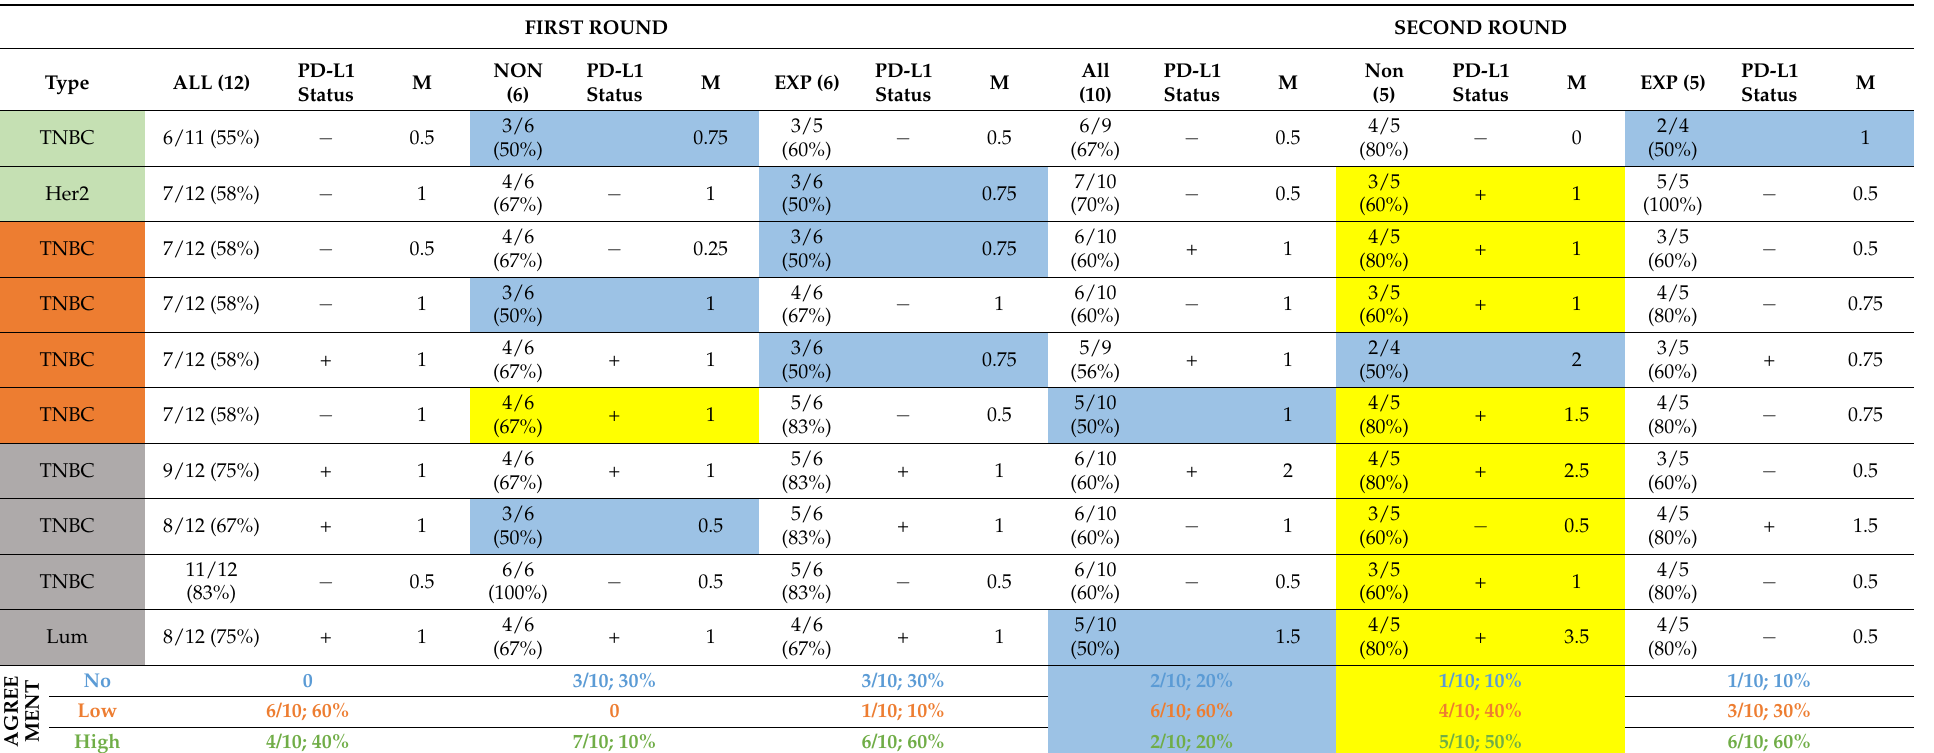
Table 5. Distribution of ten challenging (low concordance and no agreement) cases in both